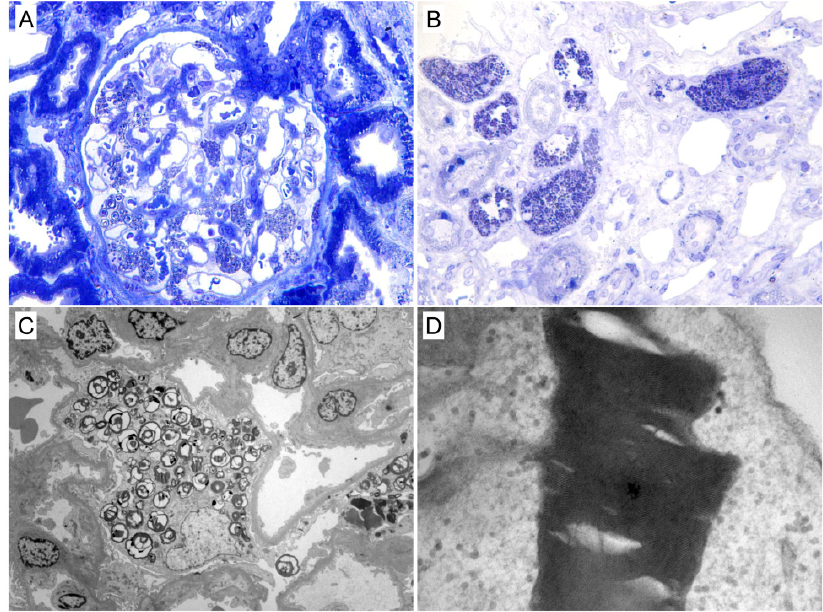
Figure 1. Kidney biopsy findings from patient No. 11 . ( A ), Light microscopy image of a semi-thin plastic section showing a glomerulus with many lamellar inclusion bodies in podocytes (toluidine blue stain, 200×); ( B ), Light microscopy image of a semi-thin plastic section showing renal medulla with tubular epithelial cells and vascular smooth muscle cells having their cytoplasm filled with inclusion bodies (toluidine blue stain, 200×); ( C ), Electron microscopy image showing electron dense, lamellate inclusions (typical “zebra bodies”) in the cytoplasm of podocytes (5700×). ( D ), Elec- tron microscopy image showing the densely packed lamellate membranes contained into a lyso- some (24,000×). 3.3. Treatment The Romanian national therapeutic protocol for prescription of FD-specific therapy states that the eligible patients for the initiating of the therapy are: males over 16 years old with confirmed FD, boys over 10–13 years old with significant manifestations or asymp- tomatic, and females of all ages with significant manifestations or with documented pro- gressive organ involvement. Significant renal manifestations (renal criteria) are repre- sented by persistent proteinuria over 300 mg/24 h and/or eGFR < 80 mL/min/1.73 m 2 [23]. Within the National Treatment Program for Rare Diseases, the following drugs are available for FD-specific therapy: agalsidase beta (the first drug used in Romania, used since 2006), migalastat (available since 2019) and agalsidase alfa (available since 2021). In our cohort, 19 patients were treated with agalsidase beta. One of them was switched from agalsidase beta to migalastat. One naïve patient was treated with migalastat. At the moment of kidney biopsy, five patients were treated with enzyme replacement therapy (ERT), beta agalsidase beta 1 mg/kg every 2 weeks, for 75 ± 57 months (range 12– 144). Three of these patients were in group 1, and two patients were in group 2. Sixteen patients were treatment-naïve at the moment of kidney biopsy. Fifteen patients started Fabry disease-specific therapy after kidney biopsy. A comparison analysis of patients who started the treatment before kidney biopsy and those who began the treatment after kid- ney biopsy showed no differences in terms of the combined EP and histological lesions (Table 5).